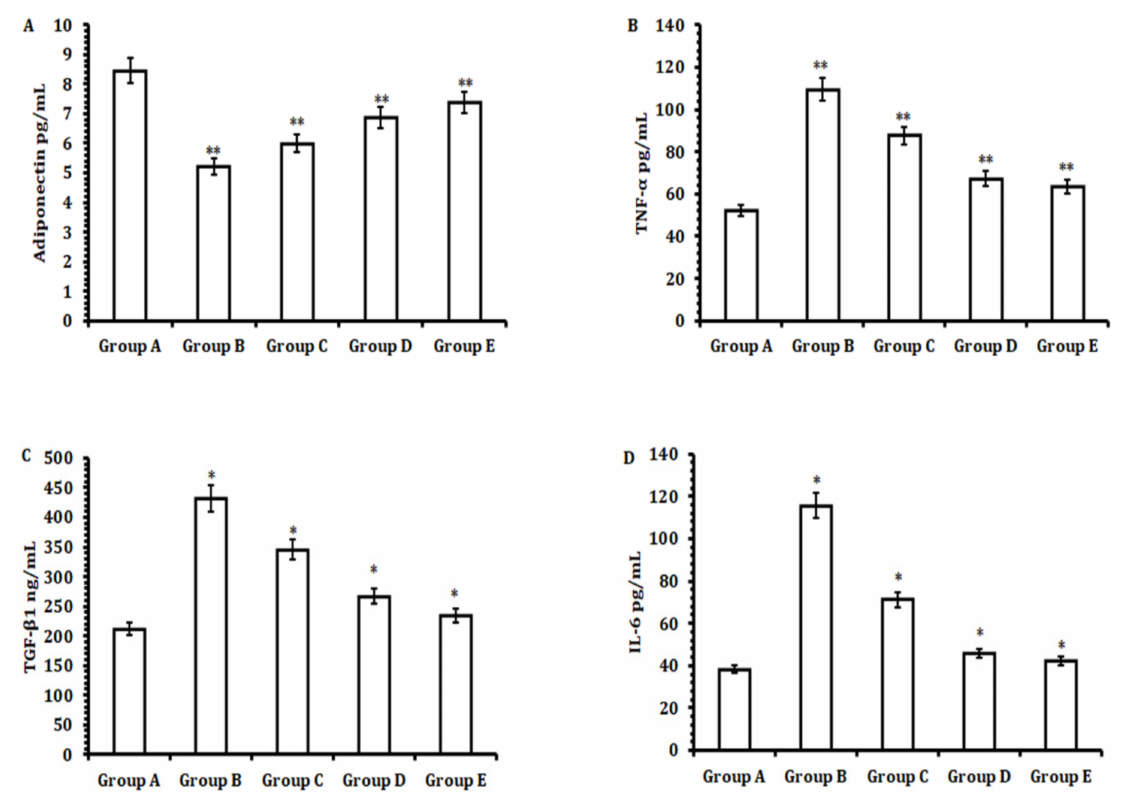
Figure 2. Effect of TA extract on anti-inflammatory (adiponectin) and pro-inflammatory cytokine markers (TNF- α , TGF- β , and IL-6) of liver tissues initially treated with CCl 4 to induce liver toxicity. ( A ) Adiponectin level, ( B ) TNF- α level, ( C ) TGF- β level, and ( D ) IL-6 level. The experiments were performed three times or more than three times, and the represented data are the mean values ± SEM. A p -value less than or equal to 0.05 was considered to be statistically significant; * p ≤ 0.05, ** p ≤